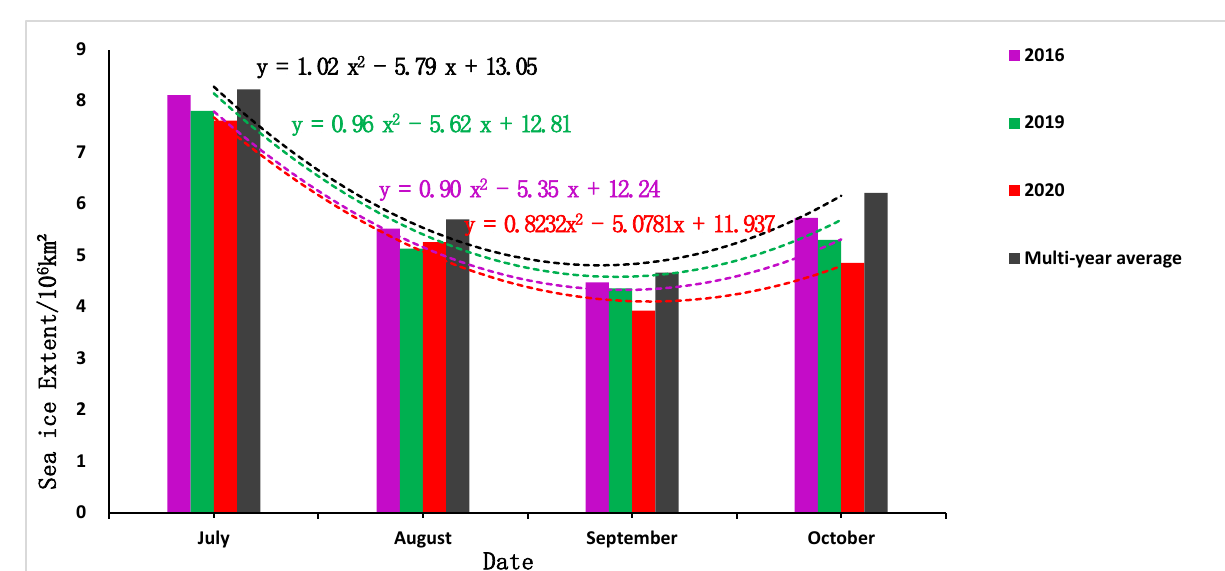
Figure 4. Histogram of monthly average sea ice extent in Arctic summer for 2016, 2019, 2020 and multi-year average. (The green dashed line is the fitting trend line of the sea ice extent in the summer of 2016, the purple dashed line is the summer of 2019, the red dashed line is the summer of 2020, and the black dashed line is the multi-year average).